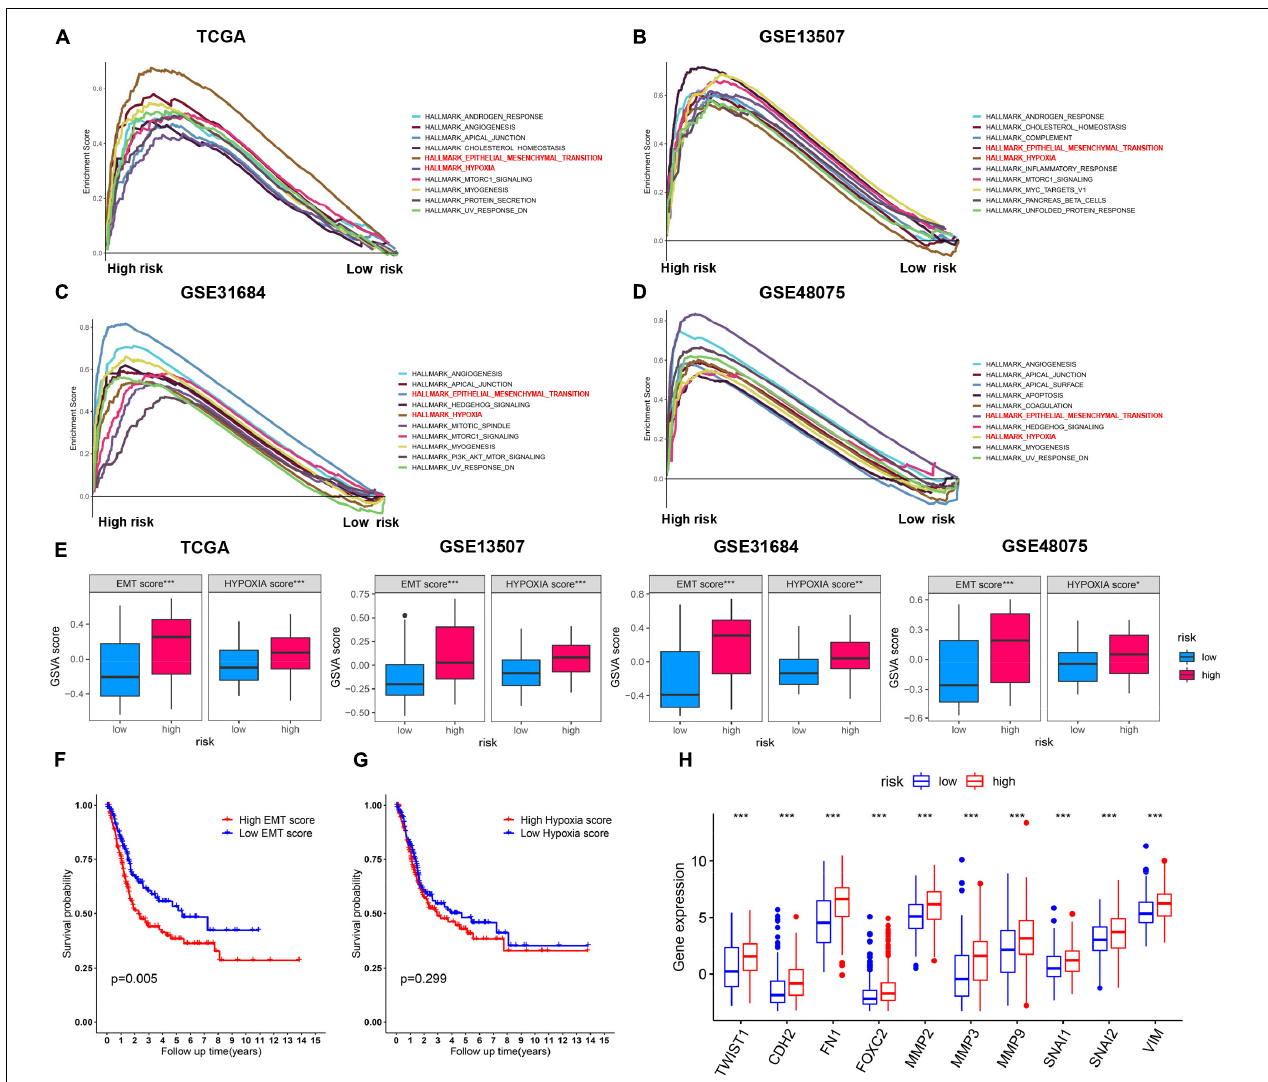
FIGURE 7 | Validation of the expression patterns of risk model. (A–D) Top 10 enriched hallmark gene sets with high and low risk score in TCGA, GSE13507, GSE48075, and GSE31684 datasets. (E) GSVA score of EMT and hypoxia gene set in the above four BC cohorts. (F,G) Kaplan–Meier survival curves for BC patients classified by EMT and hypoxia score. (H) The correlation analysis between the expression levels for EMT-related genes and the risk subgroups. *** p <